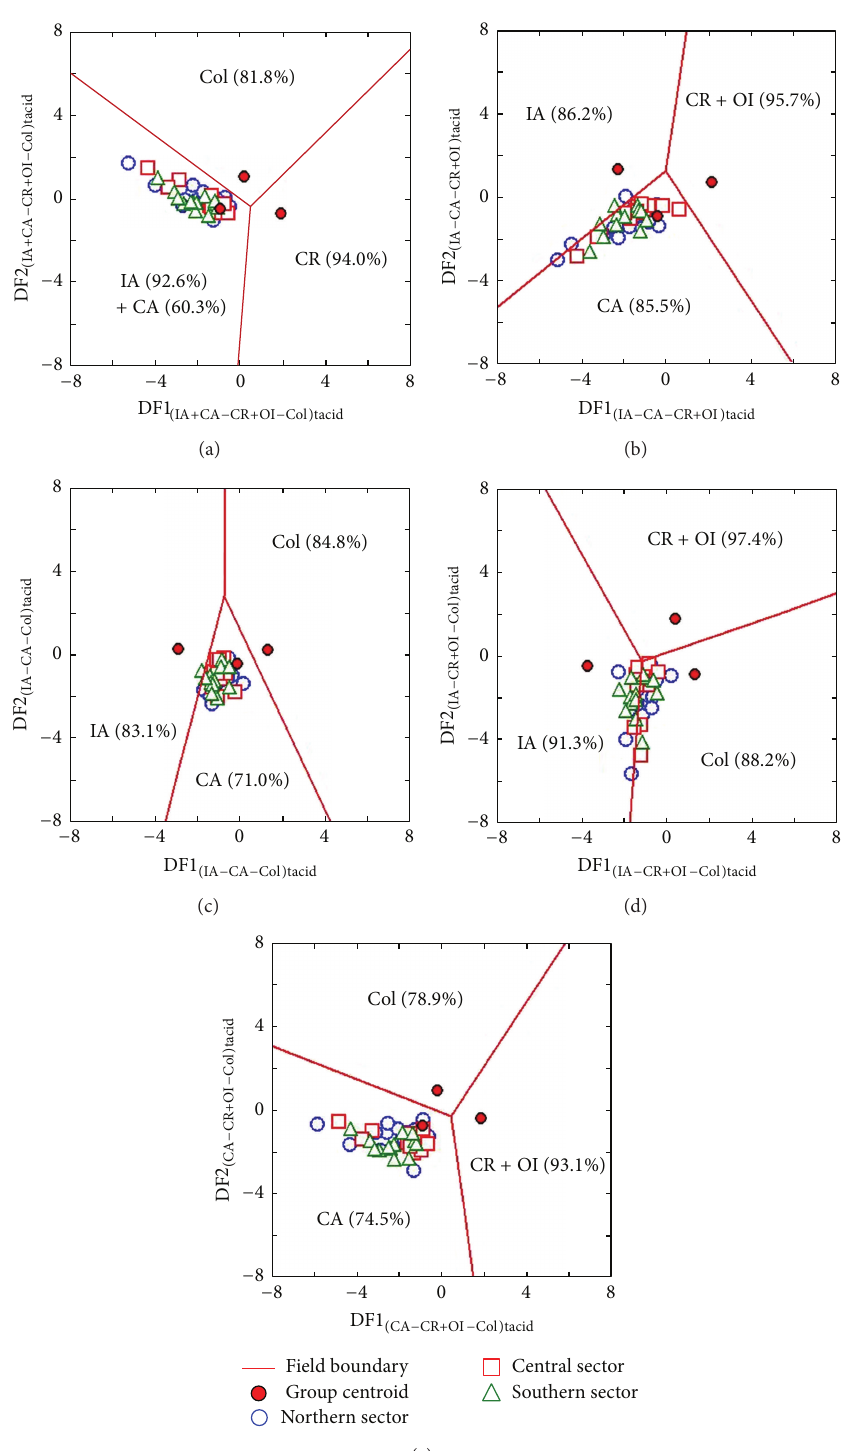
Figure 8: Discriminant-function multidimensional diagrams based on ln-transformed ratios of immobile trace elements for tectonic discrimination of acid Sierra de las Cruces magmas. The symbols are explained as inset in (a); more details are in Figure 6. The subscript “tacid” in axis names refers to trace (t) element ratios for acid (acid)